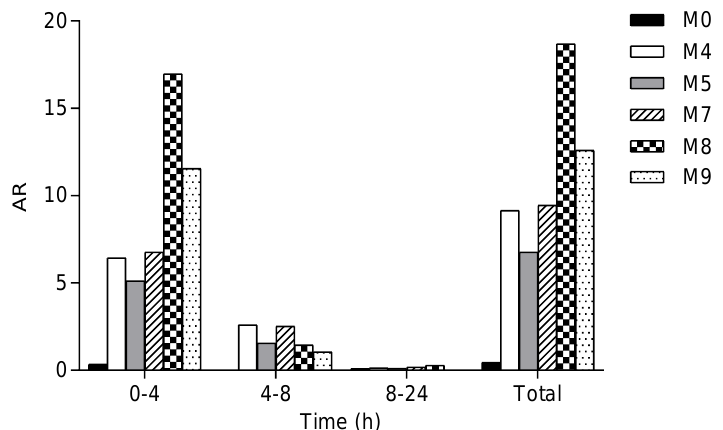
Figure 3. Time course of SP-8356 and putative metabolites detected in pooled urine following a single i.v. administration of SP-8356 at 20 mg/kg in rats. The urine levels are expressed as AR of the extracted ion chromatograms of metabolites versus the internal standard.